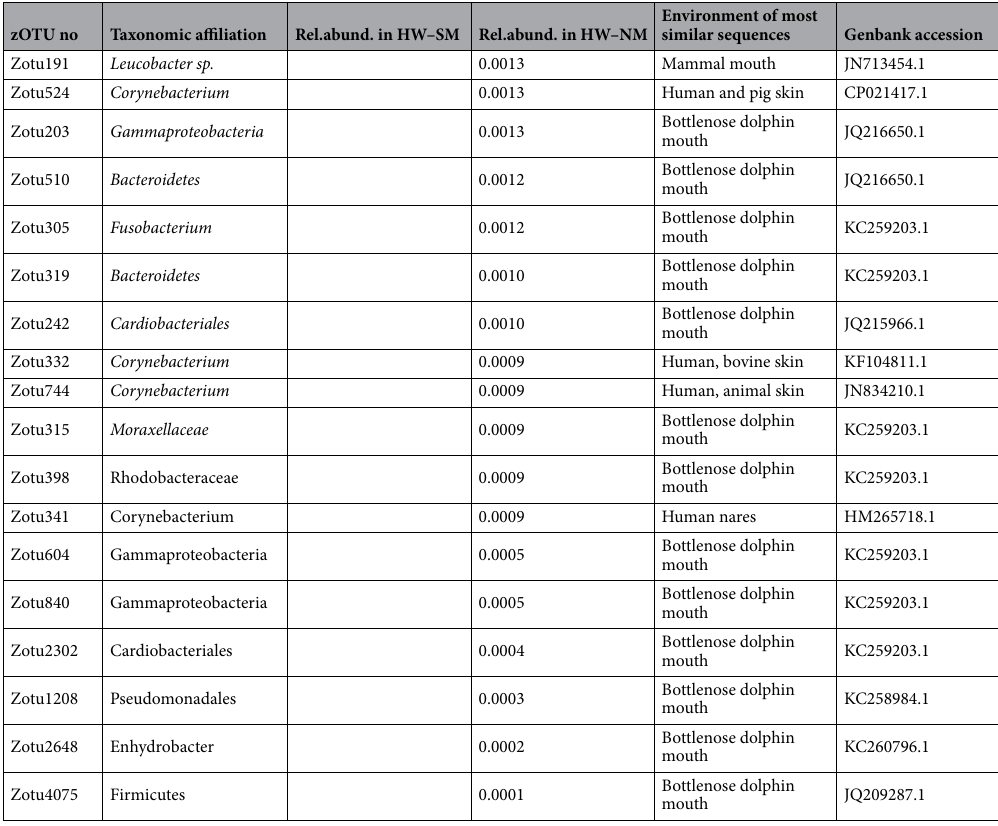
Table 3. Taxonomy, relative abundance and details of environment of core zOTUs in the blow of 20 humpback whales at the beginning of their fasting (HW–NM) and 20 humpback whales at a later stage (HW–SM), listed in descending order of the zOTUs’ relative abundance. An 80% threshold (core taxa present in 80 of individuals in each group) was used. Whereas HumpbackNM samples showed a large number of core zOTUs, HumpbackSM had none that were not associated with